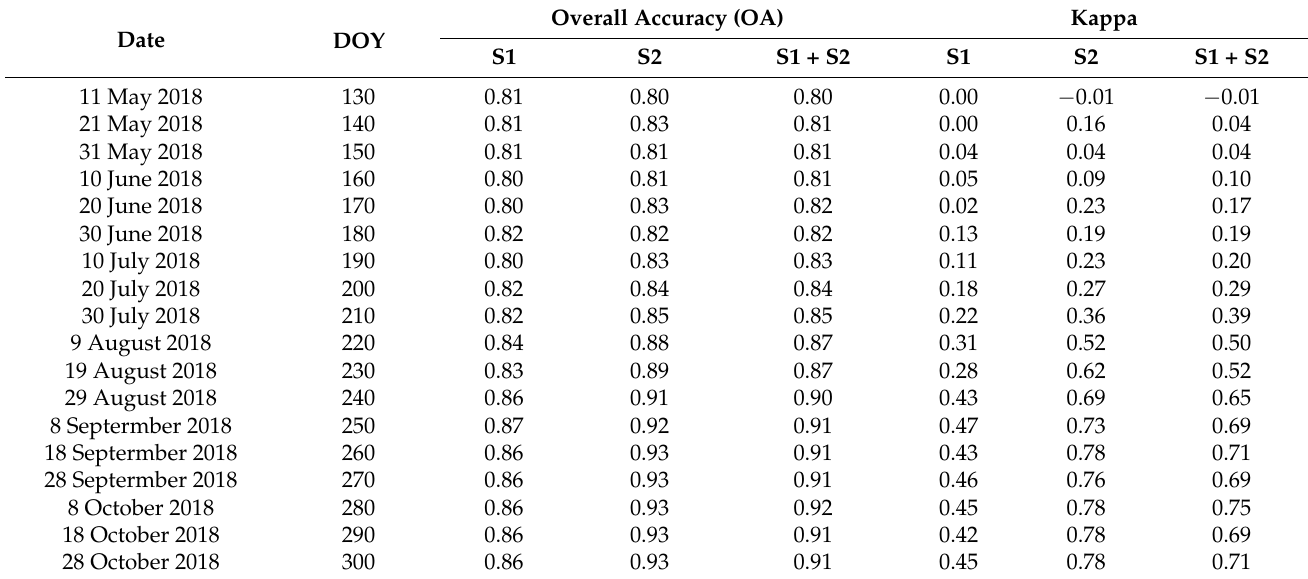
Table A1. Overall accuracy (OA) and Kappa index values for the different classification scenarios.